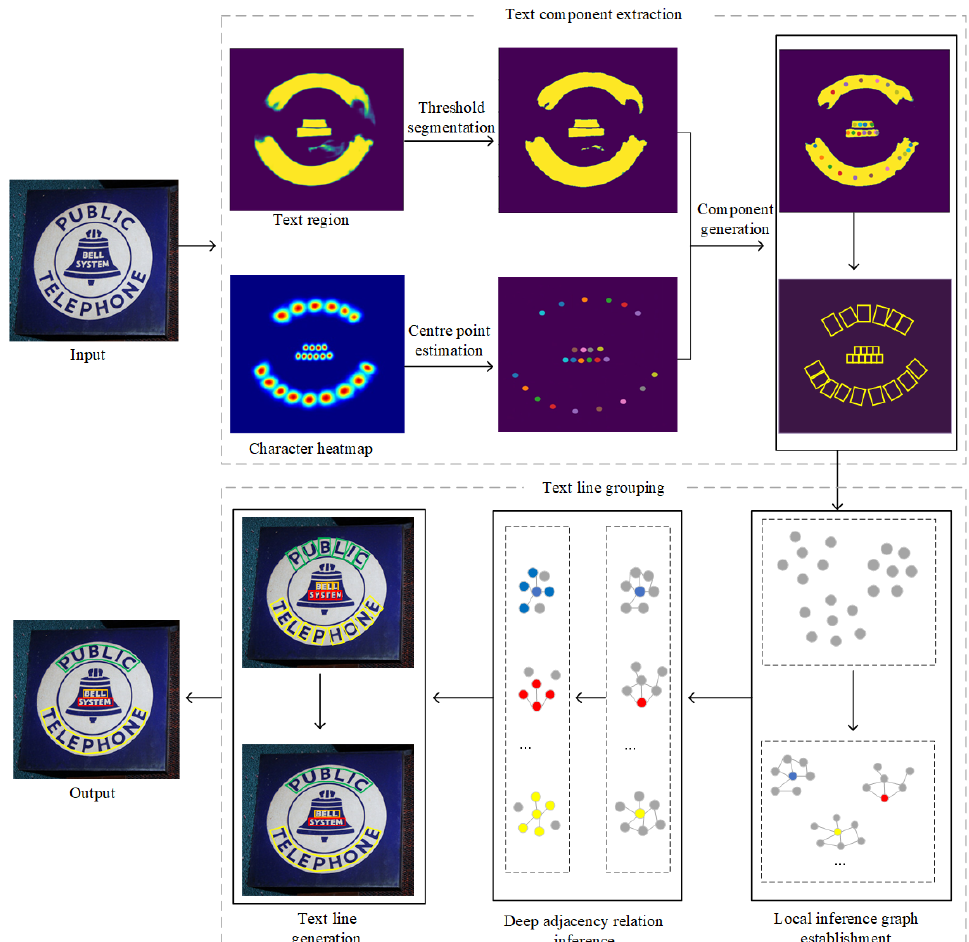
Figure 1. Overview of our overall architecture. Our network mainly consists of four parts: Text component extraction, local inference graph establishment, deep adjacency relation inference, and text line